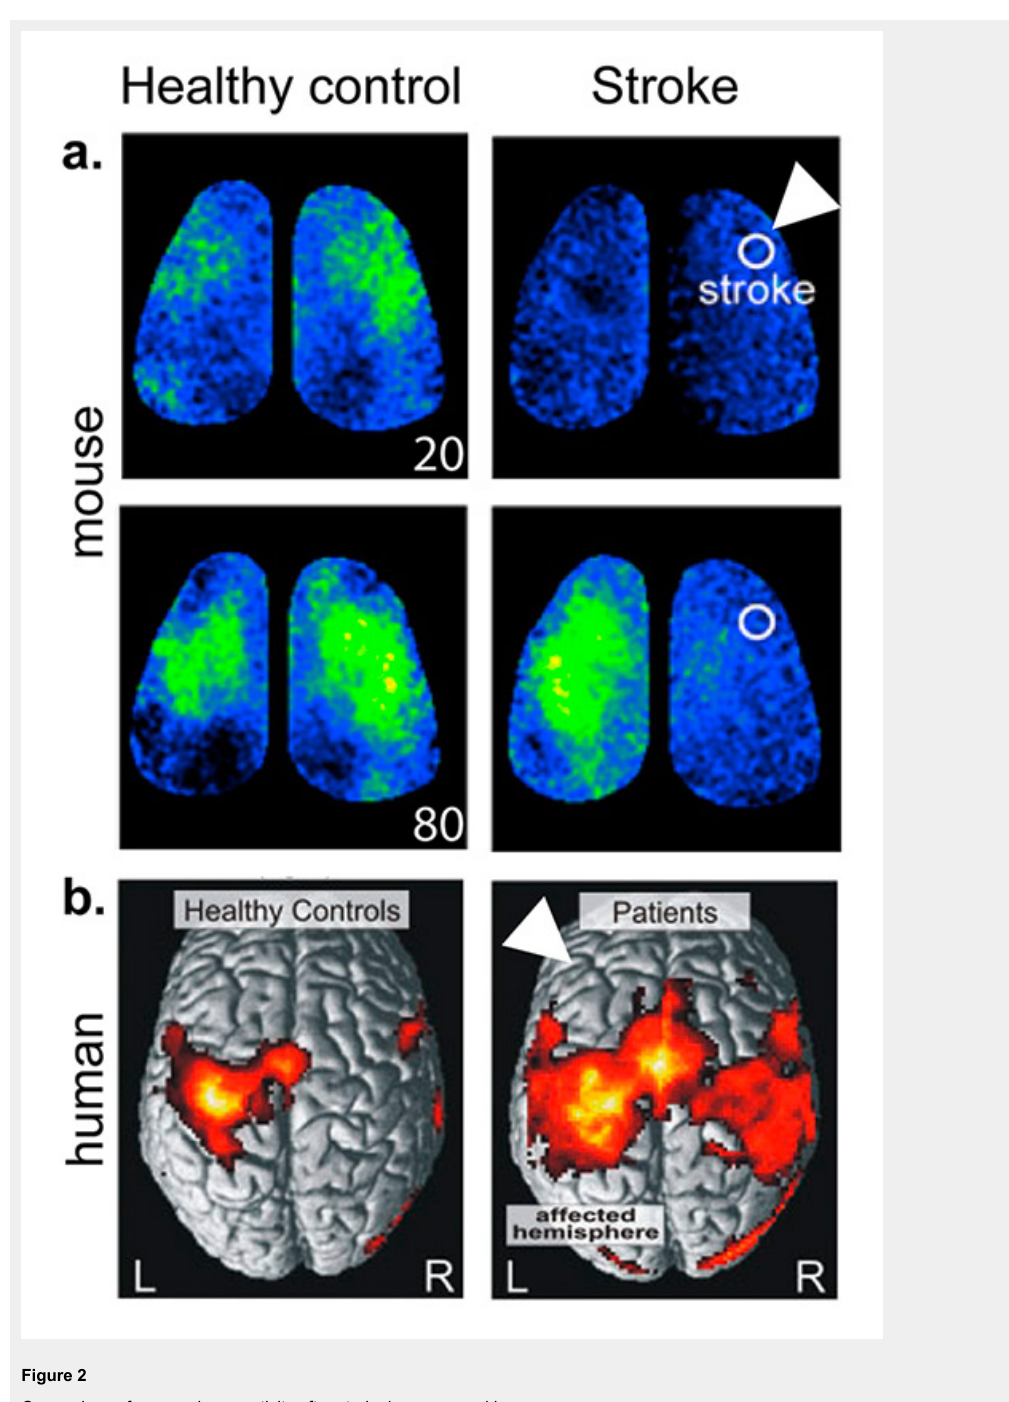
Comparison of neuronal connectivity after stroke in mouse and human. a. In-vivo imaging of mouse cortex during left forelimb stimulation shows sensory-evoked polarisation in control mice emerging immediately (20 ms) in a confined area representing left forelimb function. In contrast, forelimb stimulation after stroke resulted in a more diffuse signal encompassing mainly the contralateral hemisphere. Additionally, there is a significant shift in timing of signal propagation, with a delayed and prolonged response after stroke (compare signal maps at 20 and 80 ms after forelimb stimulation). b. Connectivity analysis based on significantly activated voxels (BOLD signal, fMRI) during movement of the right hand shows a distinct single- hemispheric cortical pattern in healthy controls. Hand movement in stroke patients were associated with enhanced and more extended neural activity in both hemispheres. White arrowheads mark the affected hemispheres.( Adapted from Mohajerani et al. 2011 [45] and Grefkes et al. 2008 [43], with